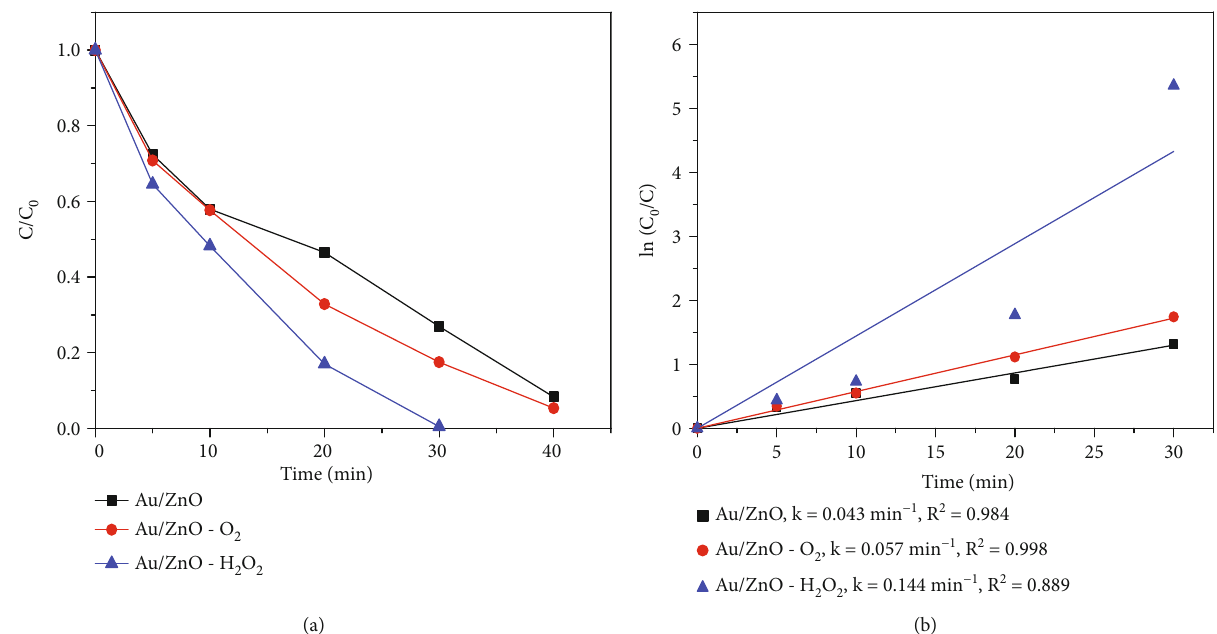
Figure 14: (a) E ff ect of oxidizing agent on degradation of TA and (b) the kinetic curves. The reaction conditions: catalyst dosage of 0.5 g/L, TA concentration of 10mg/L, pH solution of 6.0, and Hg lamp 250W.